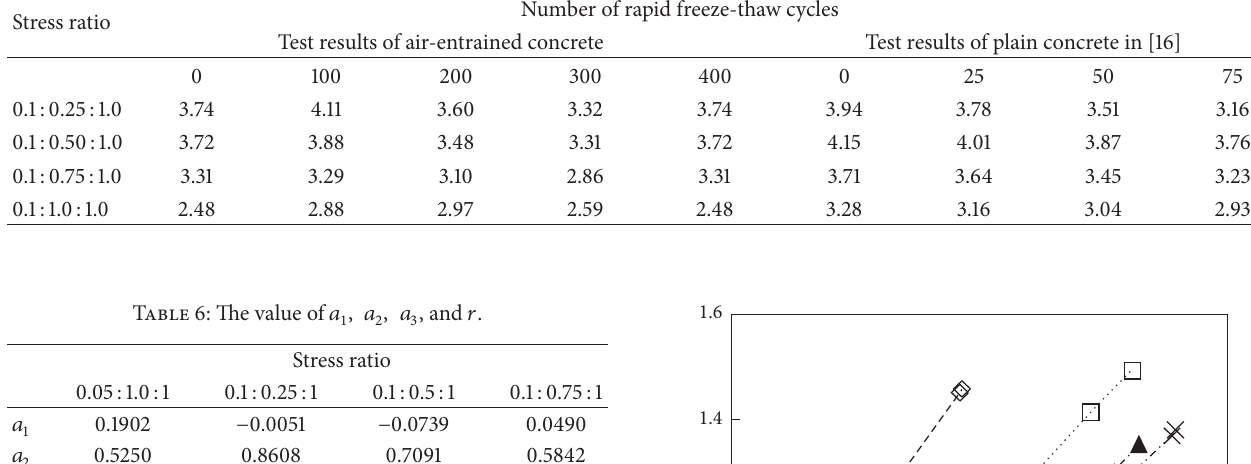
Table 5: Increased percentage of triaxial compression strength over uniaxial compression strength (%). Stress ratio